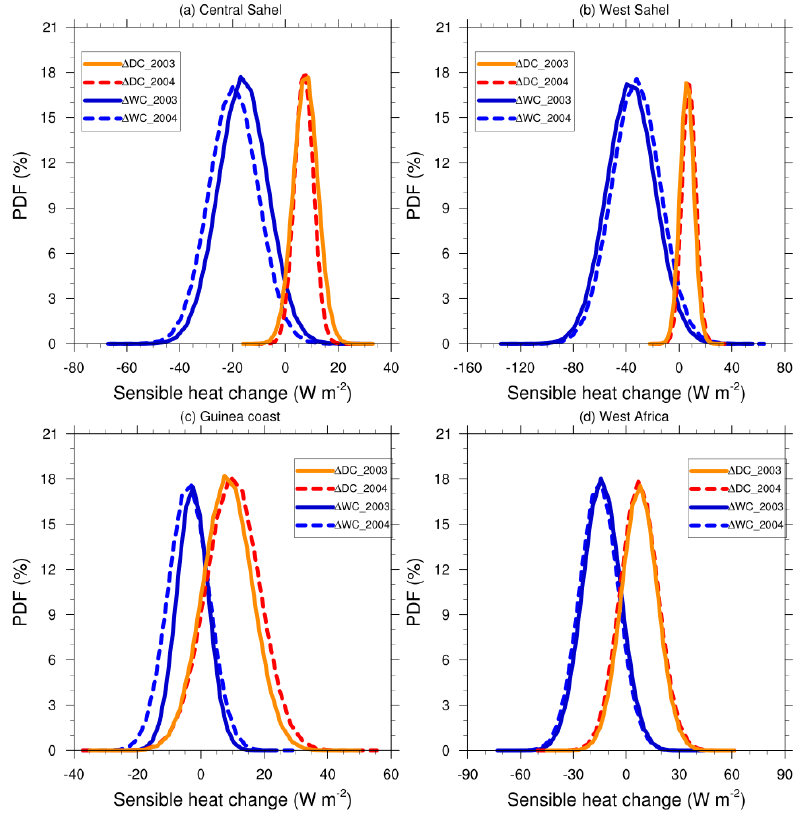
Figure 15. Same as Fig. 13 but for sensible heat fluxes (in Wm − 2 ).